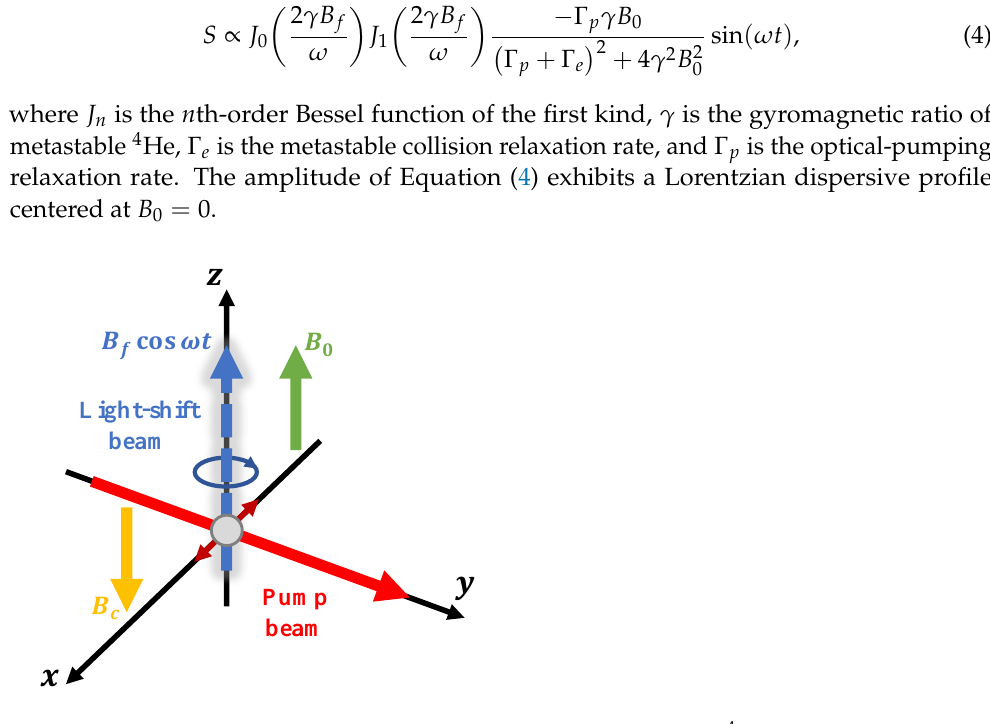
Figure 1. Field geometry of the optically modulated alignment-based 4 He parametric-resonance magnetometer operated in the closed-loop mode. B 0 , quasi-static field to be measured; B f , fictitious field; B c , compensating field. The gray circle at the center of the coordinate system represents 4 He atomic ensemble. In the open-loop mode, the B c field is